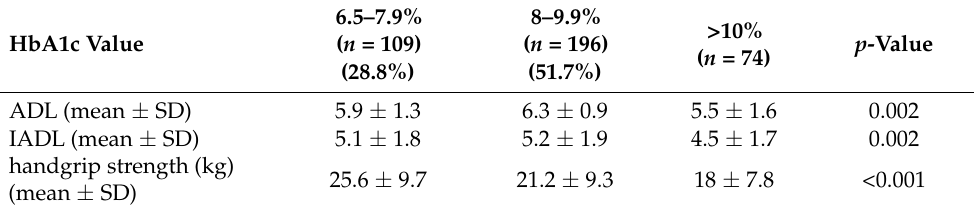
Table 6. Relationship between blood glucose regulation and geriatric